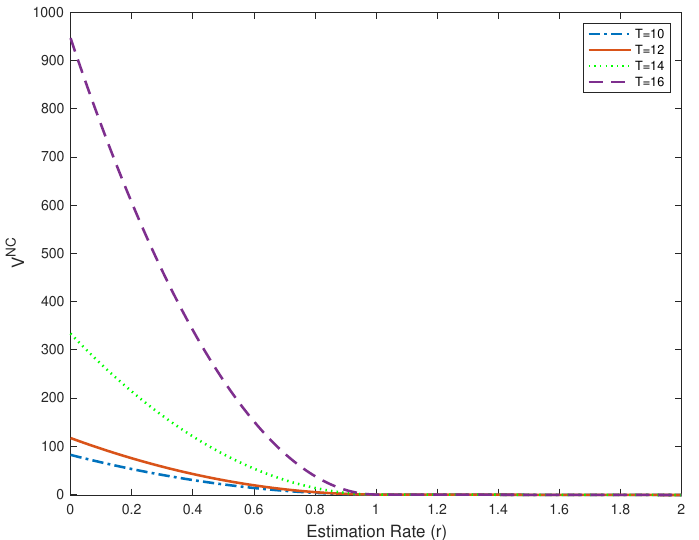
Figure 2. Normalized value of information for varied estimated initial pollution stock under different time intervals (X-axis denotes the estimation rate, Y-axis denotes the value of V NC